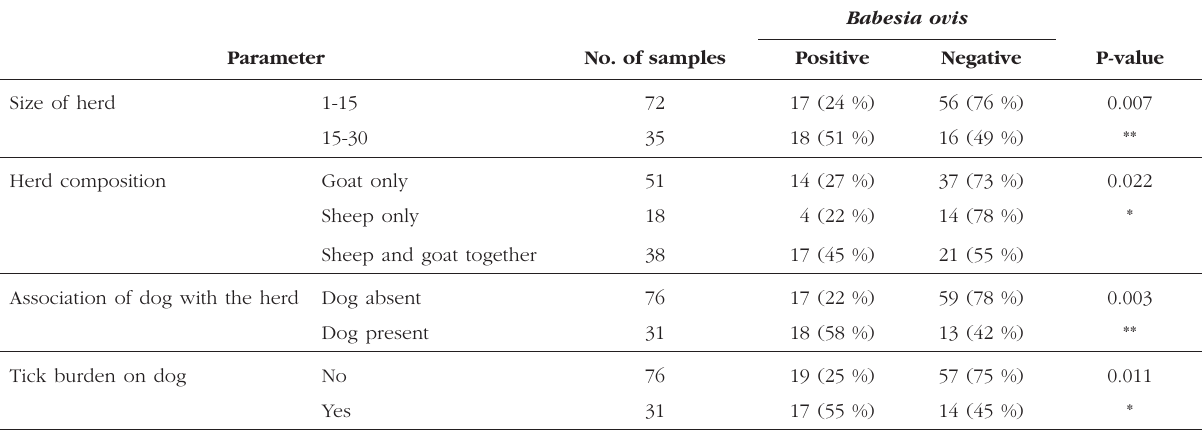
Table III. – Association between parasite prevalence in sheep and goats and the studied parameters describing animal and herd